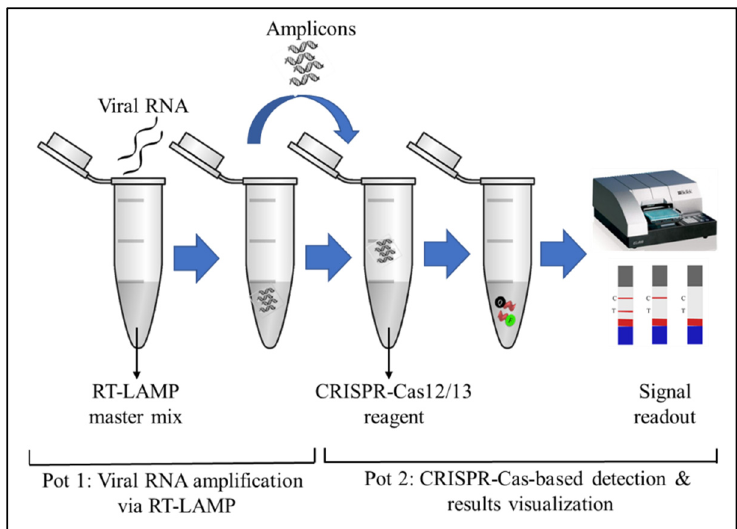
Figure 1. Schematic illustration showing a two-pot reaction for the detection of SARS-CoV-2. The viral RNAs are amplified via RT-LAMP in the first pot. The amplicons are then used for the CRISPR- Cas12/13-based detection, followed by the visualization of the result through colorimetry or a fluorescence assay in the second pot.